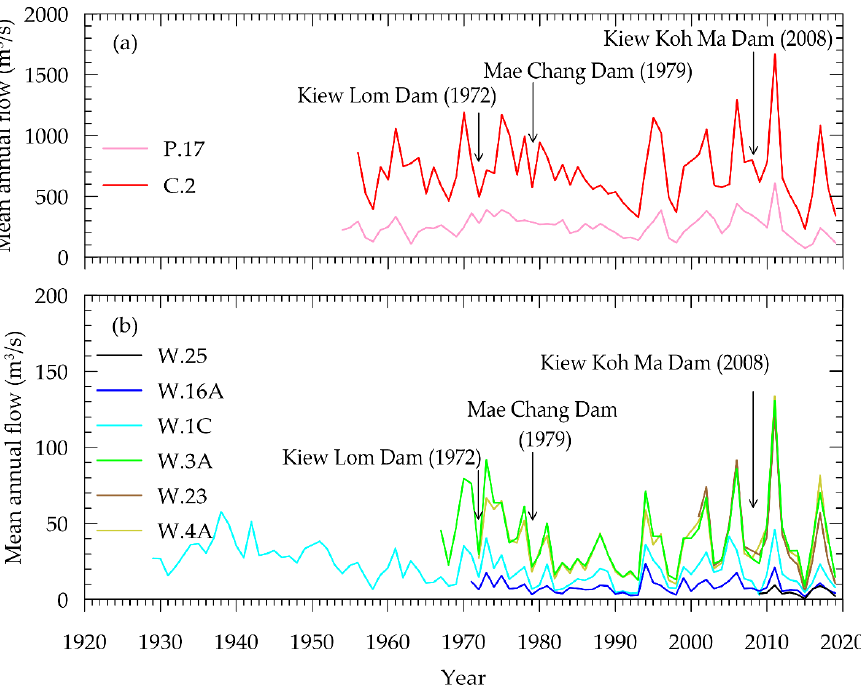
Figure 4. Time series of annual runoff at the RID hydrological stations between 1929 and 2019: ( a ) P.17 and C.2; ( b ) W.25, W.16A, W.1C, W.3A, W.23, and W.4A.